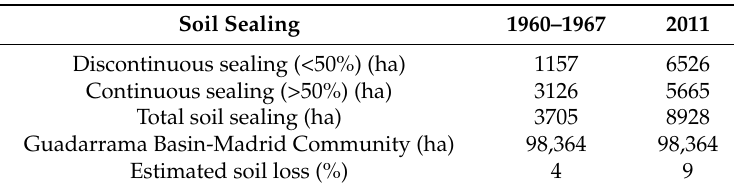
Table 2. Estimated soil